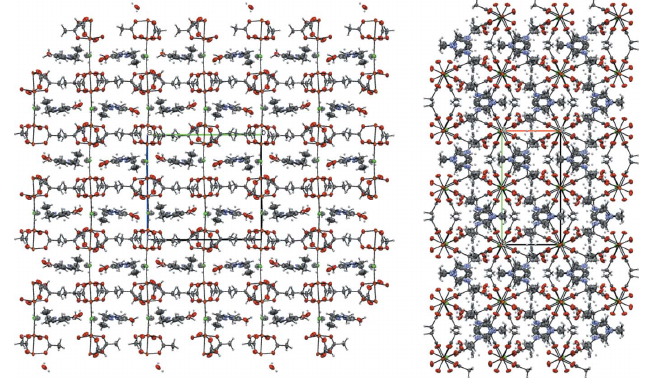
Figure 6 The packing of compound 2 , viewed along the a and c axes.